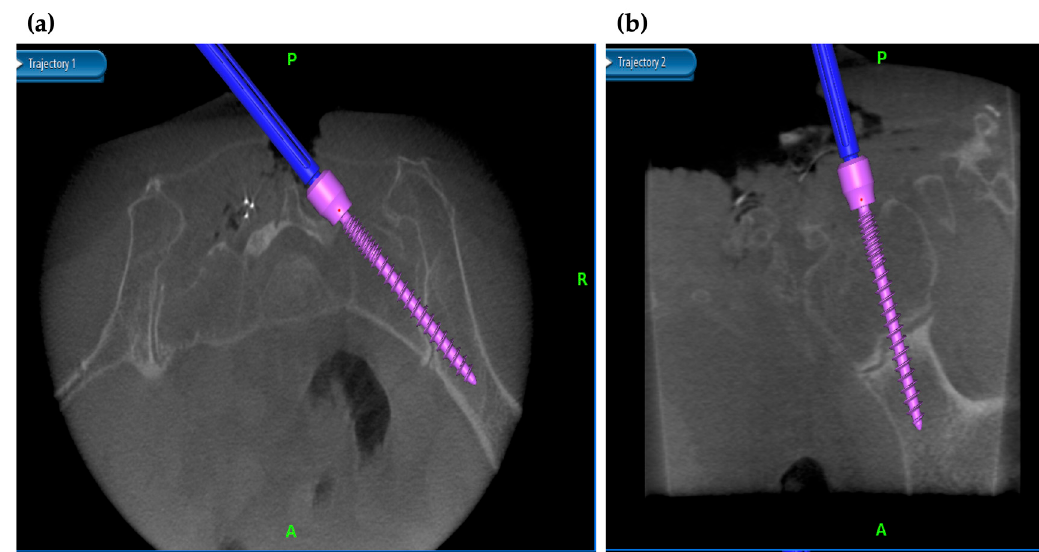
Figure 5. Navigation in minimally invasive spinal stabilization. With navigation, S2AI screws of sufficient length can be inserted in the exact direction. ( a ) Intraoperative axial and ( b ) intraoperative sagittal views on navigation monitor.